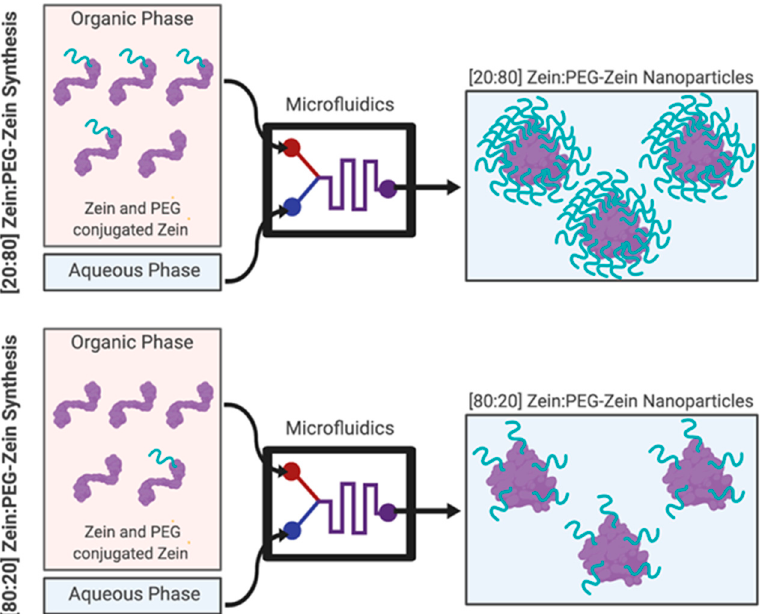
Figure 3. Illustration of the polyethylene glycol (PEG) pre-conjugation that could be utilized for the PEGylation of Zein via a PEG-N-hydroxysuccinimide (NHS) ester reaction. Example synthesis of the [20:80] and [80:20] Zein:PEG-Zein nanoparticle formulations depicted above.